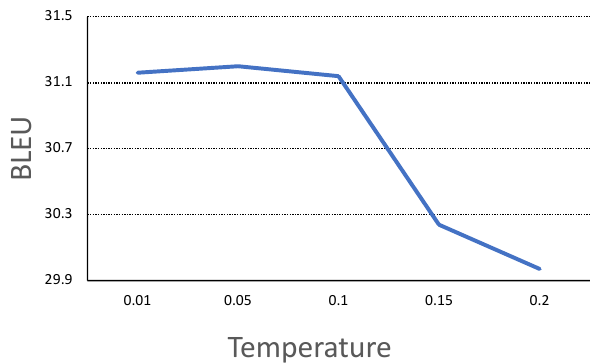
Figure 5. The results from different temperatures on the IWSLT14 DE →